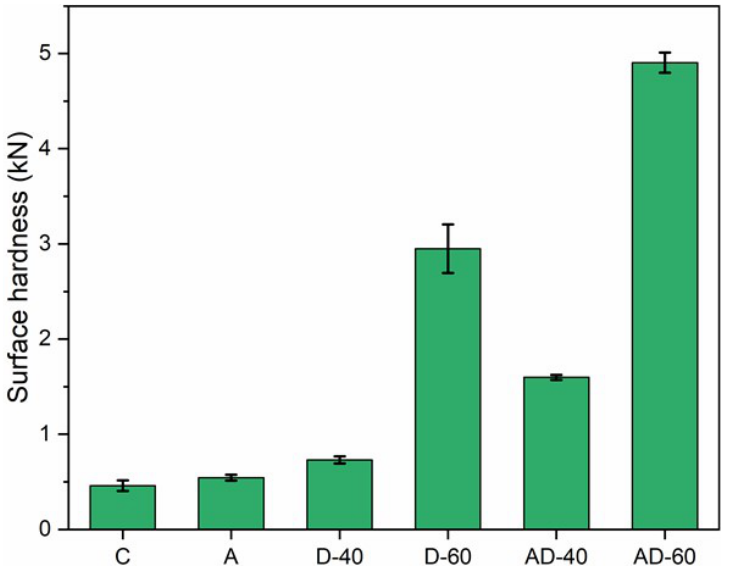
Figure 6. Surface hardness of the control and treated wood samples. Densification can improve the surface hardness of wood. Due to the improved bulk density caused by acetylation, the surface hardness further improved by 119% and 66% with 40% and 60% compression ratios, respectively.